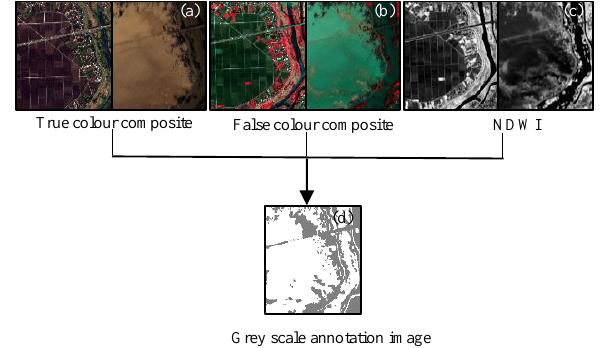
Figure 4. Annotation data preparation ((a) True colour composite of SPOT image (b) false colour composite (c) NDWI image (d)